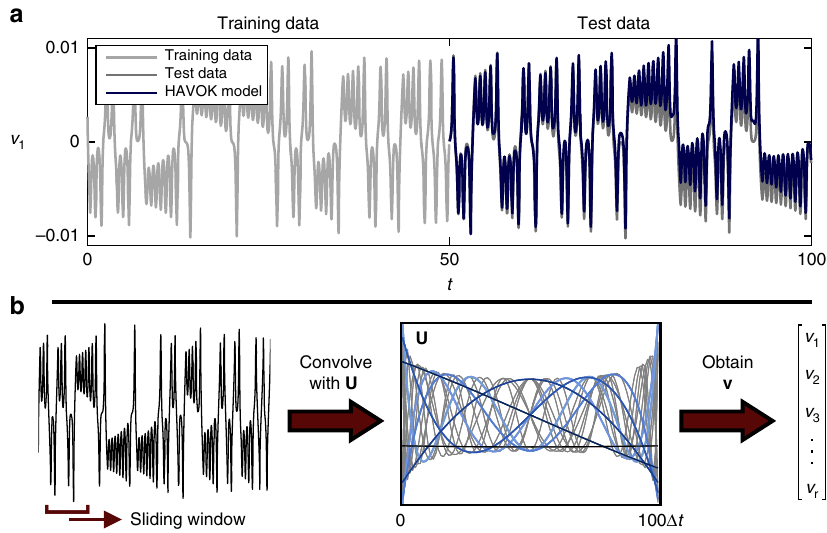
Fig. 5 a The linear model obtained from training data ( light gray ) may be validated on a new test trajectory. Extracting the v r signal as an input to the linear model provides an accurate reconstruction ( blue ) of the attractor on the test data ( black ). b Illustration of eigen-time-delay modes in U for the Lorenz system with q = 100 corresponding to a window size of 100 Δ t = 0.1 time units. Measurements are convolved with U to obtain v . The U modes resemble polynomials, ordered by energy (i.e., constant, linear, quadratic, etc.). This structure in U is common across most of the examples, and provides a criterion to determine the appropriate number of rows q in H and the rank